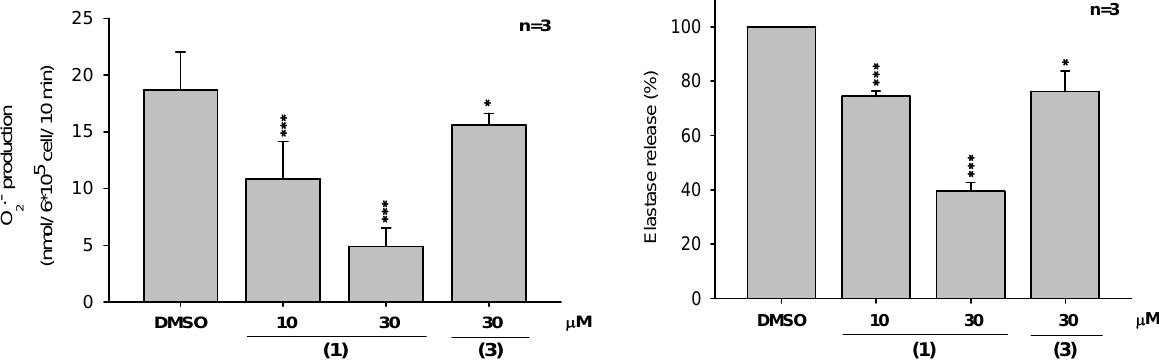
Figure 4. Effect of (7 S *,8 R *,7’ R *,8’ S *)-icariol A N - p -coumarylanthranilic acid ( 3 ) isolated from H. aristata on generation of superoxide anion (left) and elastase release (right) in fMLP/CB-activated human